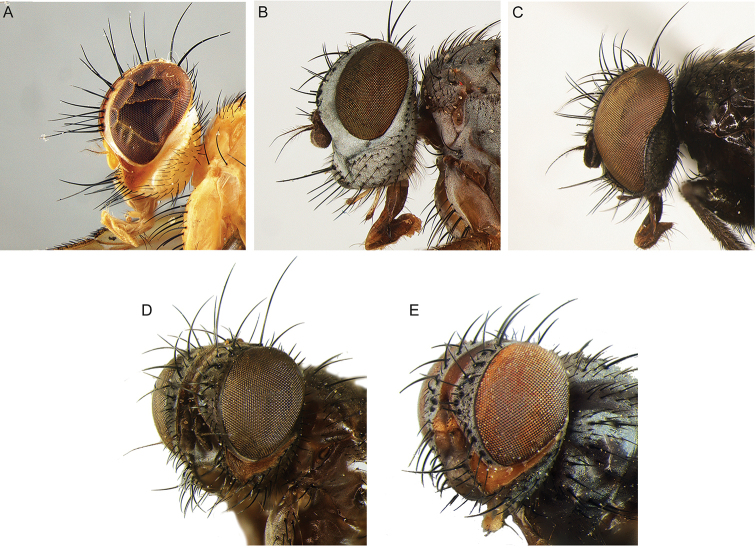
Rhinophoridae, head in lateral view. ATripetidomima
lutea ♂ (Brazil) BTromodesia
angustifrons ♀ (Israel) [paratype] CVentrops
milichioides ♂ (Tanzania) DVentrops
hannemariae ♀ (Tanzania) EVentrops
stuckenbergi ♂ (Namibia) [holotype].